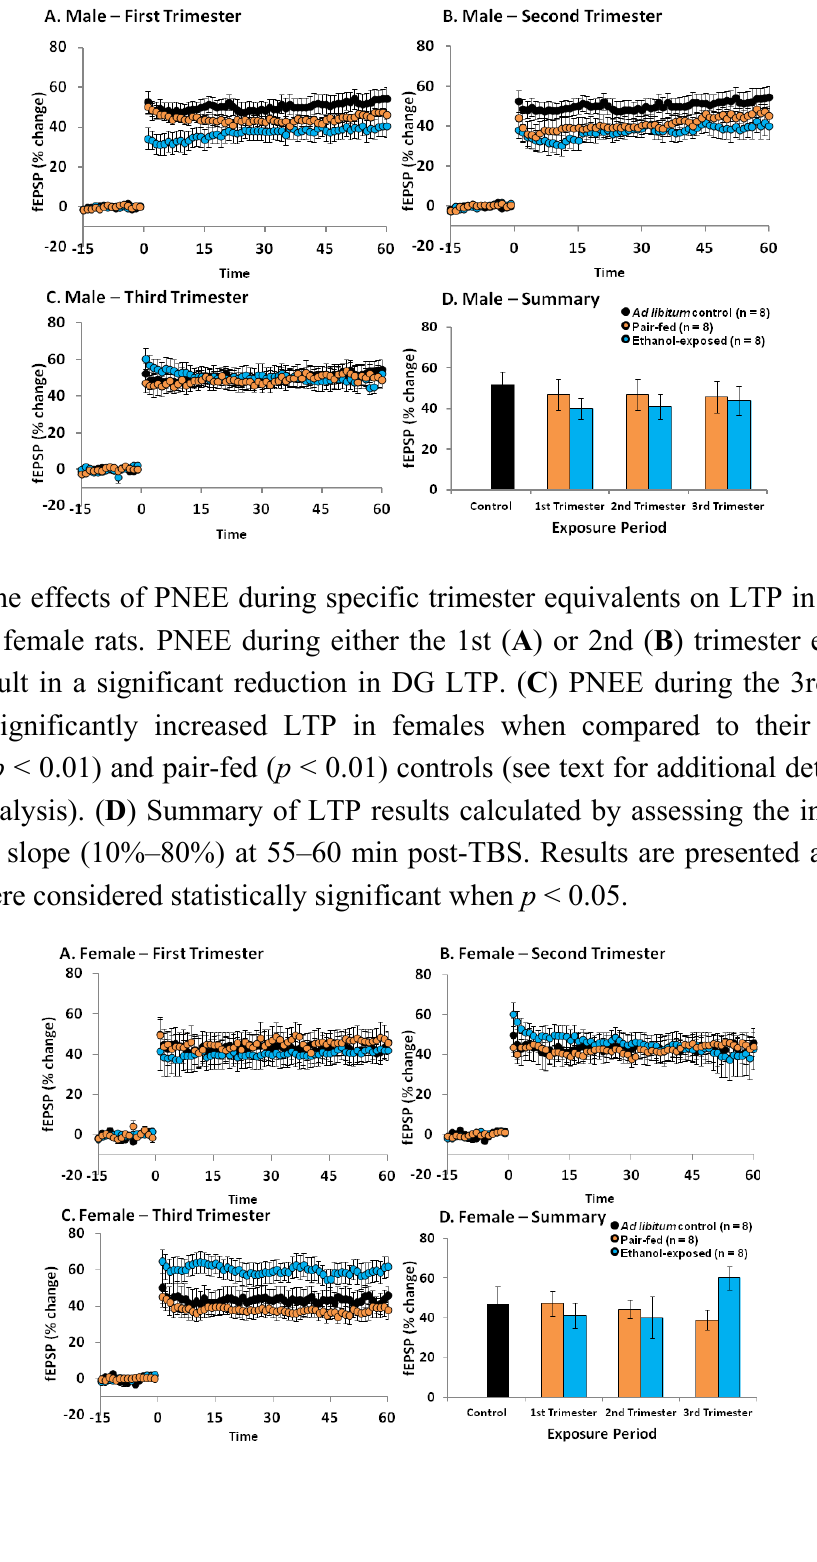
Figure 1. The effects of perinatal ethanol exposure (PNEE) during specific trimester equivalents on long-term potentiation (LTP) in the dentate gyrus (DG) of young adult male rats. PNEE during either the 1st ( A ), 2nd ( B ), or 3rd ( C ) trimester equivalents does not result in a significant reduction in DG LTP. ( D ) Summary of LTP results calculated by assessing the initial phase of the excitatory post-synaptic potentiation (EPSP) slope (10%–80%) at 55–60 min post-theta burst stimulation (TBS). Results are presented as means ± SEM and were considered statistically significant when p < 0.05.